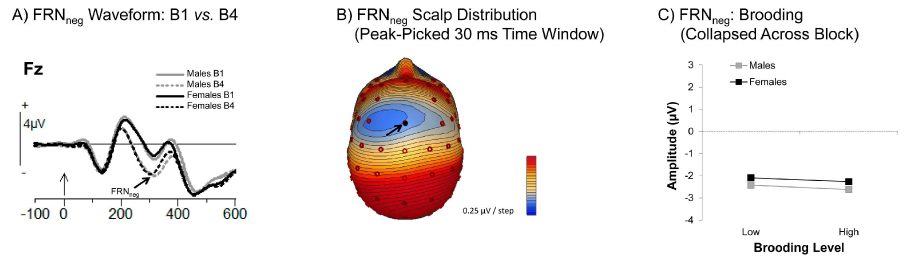
Figure 4. Feedback-Related Negativity in response to errors ( i.e. , FRN neg ). ( A ) FRN neg grand mean waveforms plotted at Fz for the first (B1) and last (B4) blocks, as a function of gender; ( B ) Scalp distribution of the FRN neg for all subjects, collapsed over all four blocks. The arrow points to Fz, which is highlighted in black; ( C ) Null effects of Brooding on FRN neg